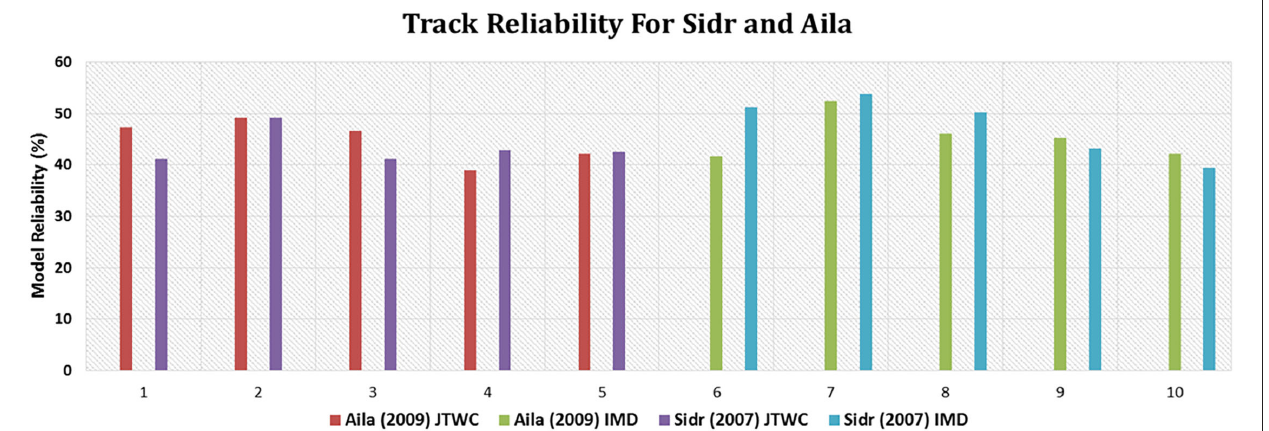
FIGURE 4 | Average track reliability for JWTC and IMD for cyclones Sidr and Aila.